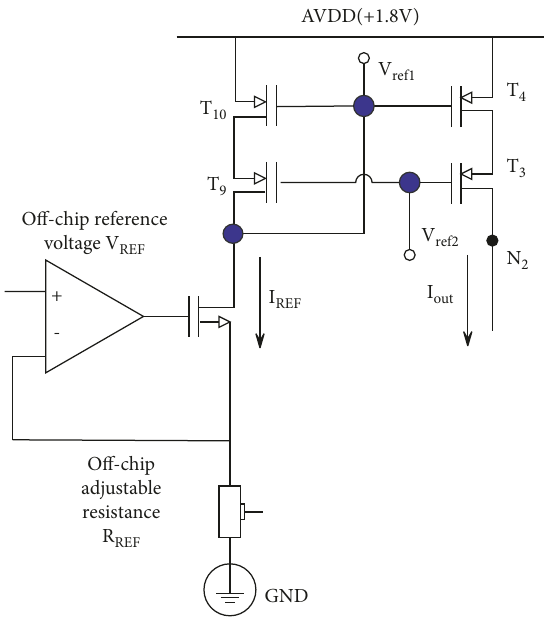
Figure 3: Low-voltage cascode current mirror and its